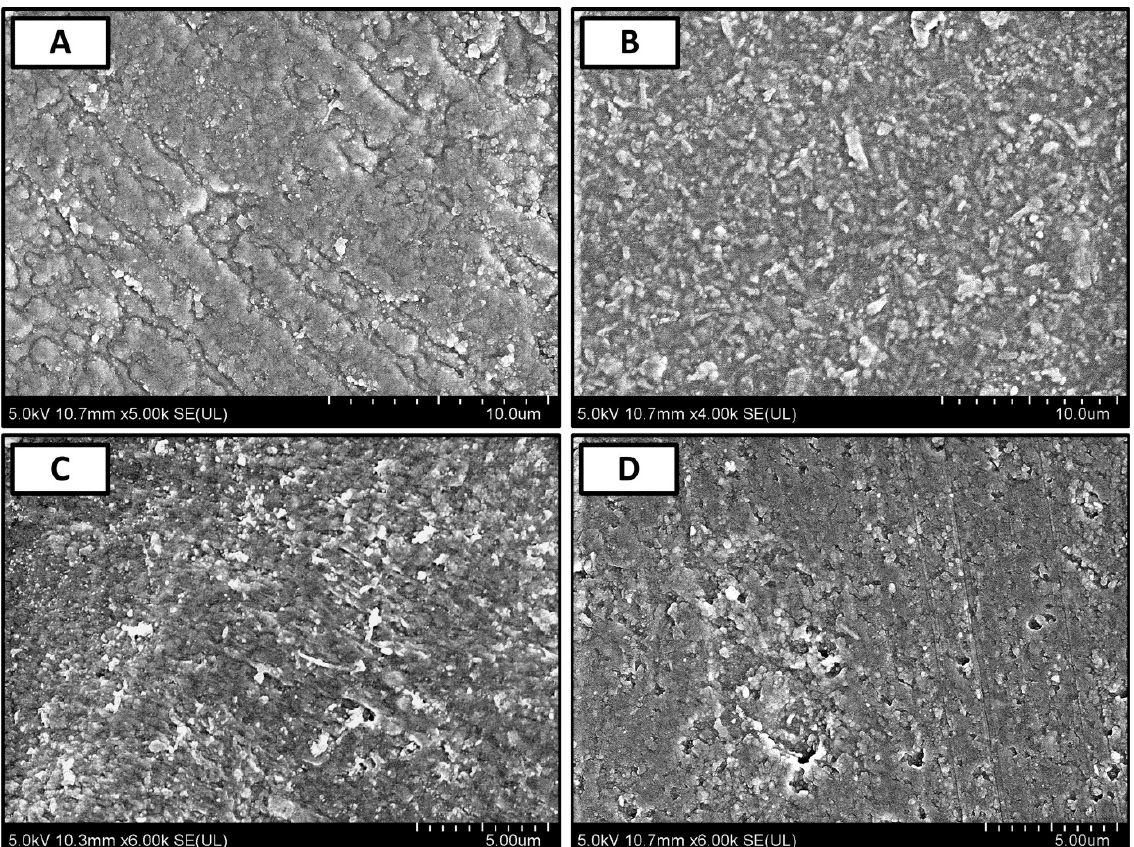
Figure 4. FE-SEM micrographs of ( A ) crosslinked alginate, ( B ) pectin, ( C ) Alg–Pec, and ( D ) Alg–Pec– Figure 4. FE-SEMmicrographsof( A )crosslinkedalginate,( B )pectin,( C )Alg–Pec,and( D )Alg–Pec–AA–LA biocomposite films.